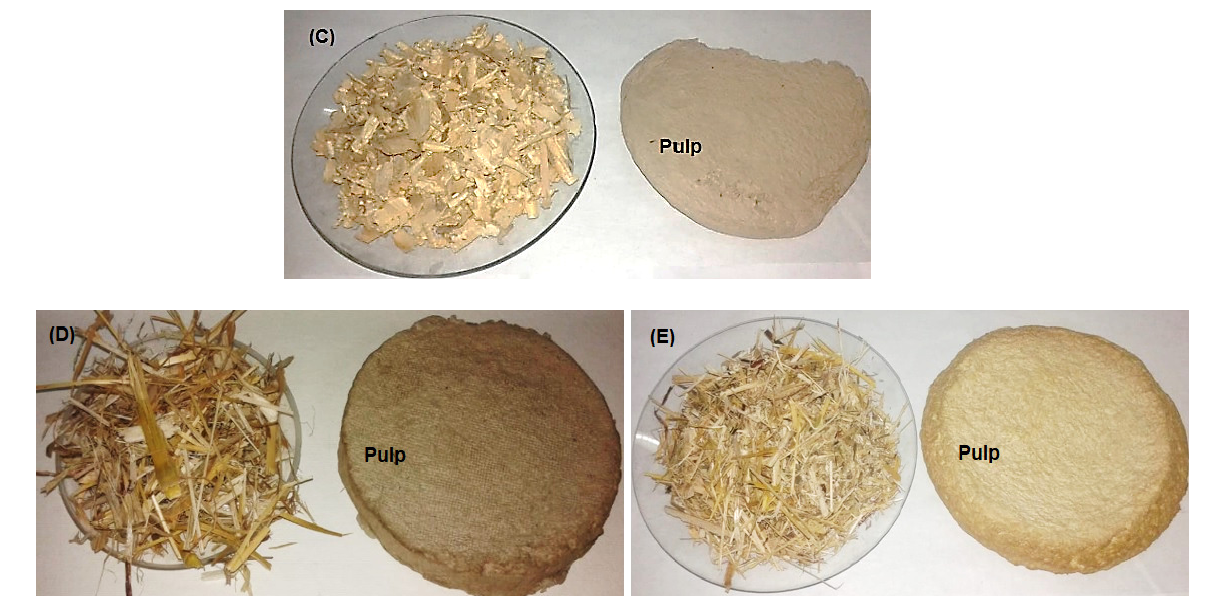
Figure 1. Kraft pulping of wood species and non-wood materials. ( A ) F. altissima ; ( B ) F. elastica ; ( C ) B. spectabilis ; ( D ) Z. mays ; and ( E ) S. bicolor.